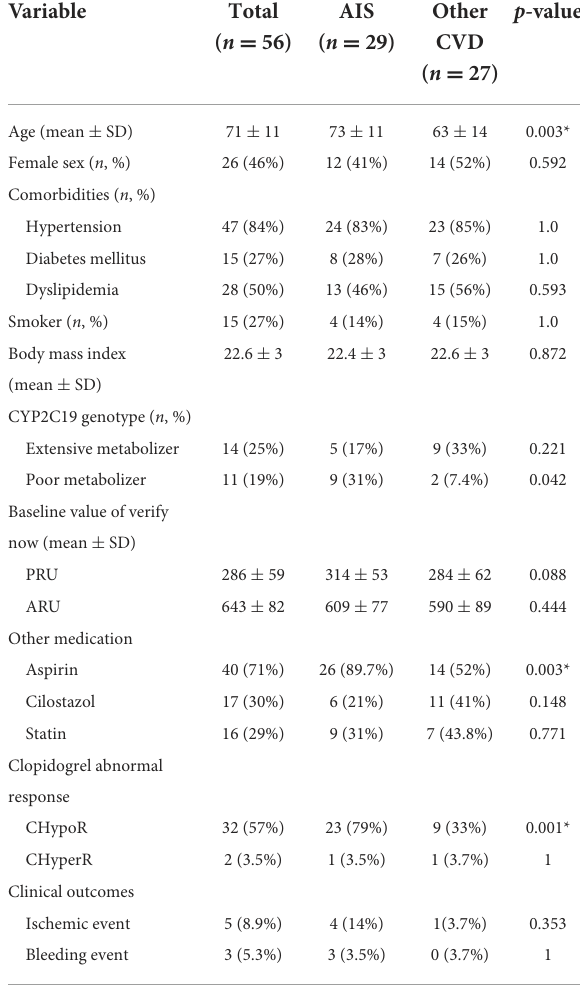
TABLE 1 Patients’ demographic and clinical